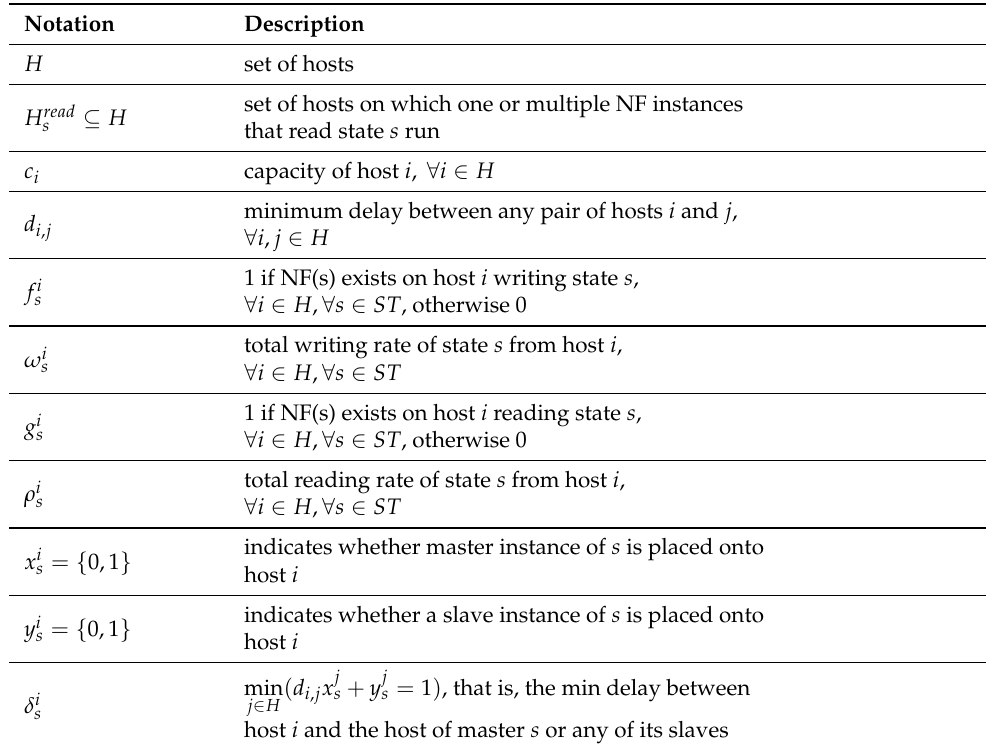
Table 4. Mathematical